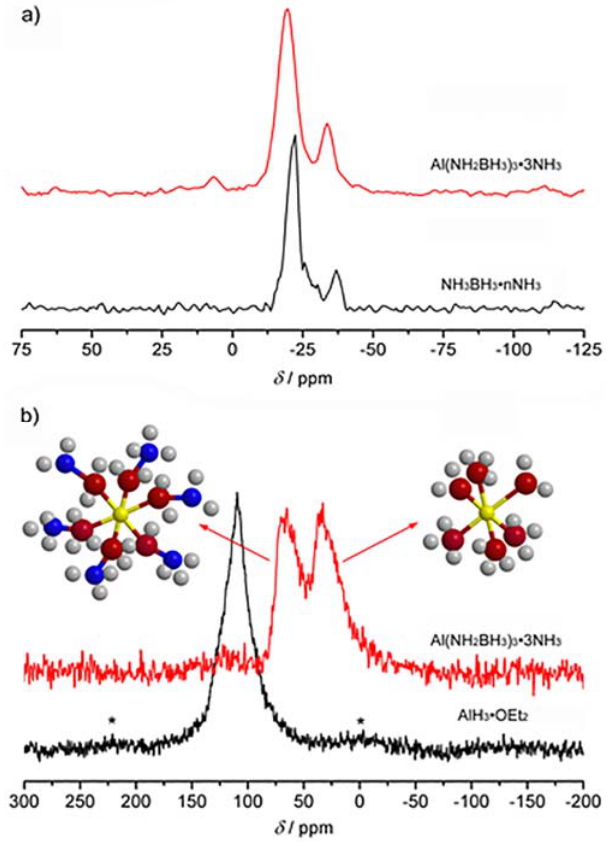
Figure 2. ( a ) 11 B MAS NMR spectra of [Al(NH 2 BH 3 ) 63 − ][Al(NH 3 ) 63+ ] and NH 3 BH 3 · n NH 3 ; ( b ) 27 Al MAS NMR spectra of [Al(NH 2 BH 3 ) 63 − ][Al(NH 3 ) 63+ ] and AlH 3 ·OEt 2 . The molecular structure of the octahedral Al complexes are also depicted (yellow balls represent Al, red for N, blue for B, and grey for